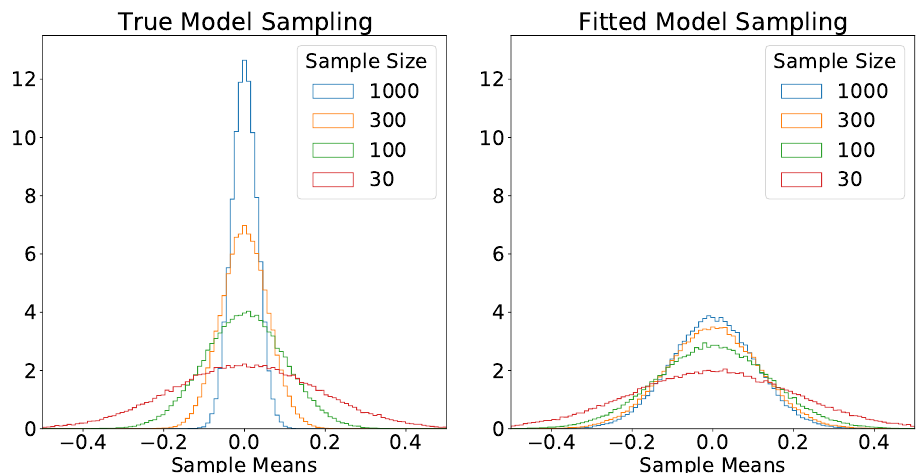
Figure 5: Distribution of the sample means in 100,000 pseudo-experiments for dif- ferent sample sizes, i.e., number of events in a given pseudo-experiment. In the left panel the events are drawn from the true theory distribution (25), while in the right panel the events are sampled from the f distribution (26) trained on n = 100 GAN events from the true distribution (25).